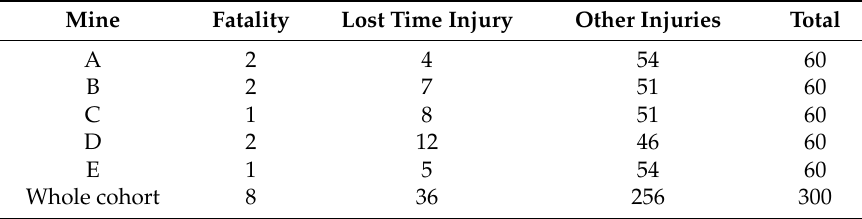
Table 2. Comparison of injury severity across the